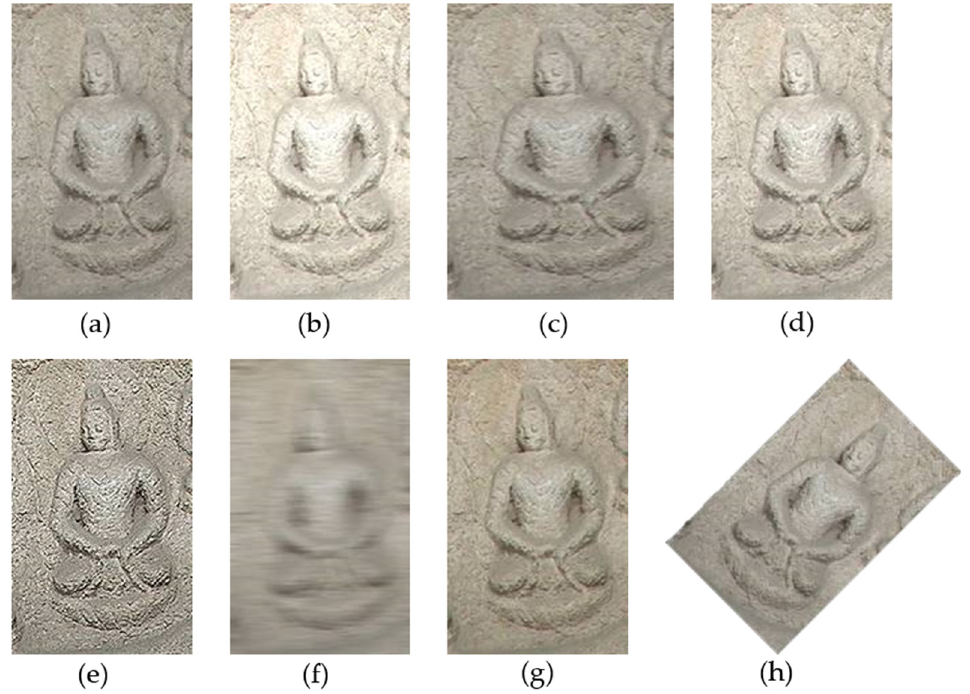
Figure 5. Original image and transformed image. ( a ) image (original); ( b ) image (light); ( c ) image (resize); ( d ) image (contrast); ( e ) image (sharp); ( f ) image (blur); ( g ) image (color); ( h ) image (rotate). Table 1. Comparison results of the three hash algorithms. Contrast Images Time (s)